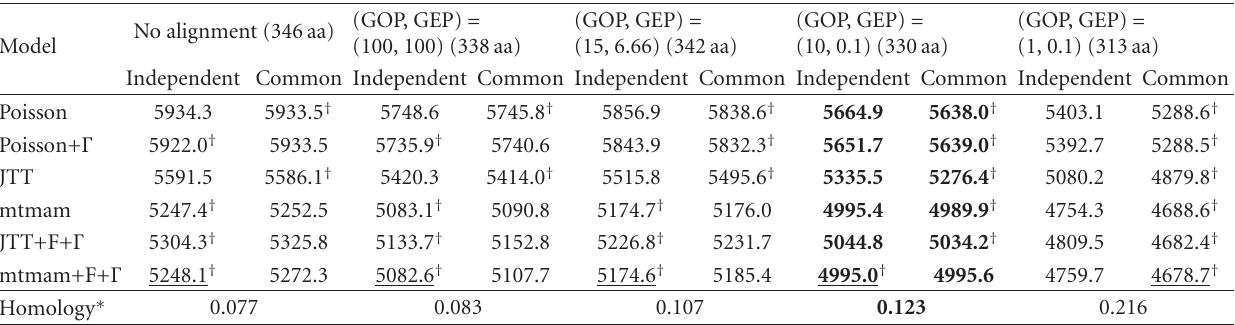
Table 2: Formal tests of the common ancestry between cytb and nd2 based on the amino acid sequence data sets aligned with various values of gap penalties (GOP and